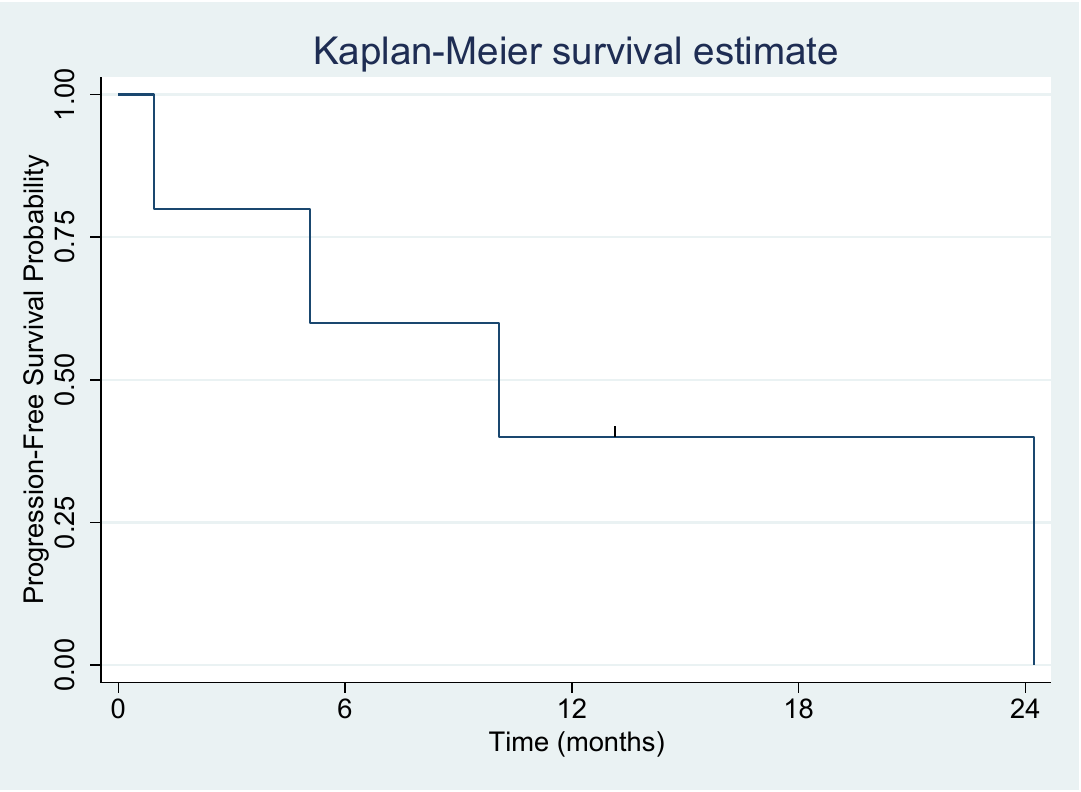
Figure 6. Overall median PFS on MMC treatment. Legend: Patient 3 did not progress and died of lung cancer, so was considered censored at the time of death. The median PFS was 10.1 months (95% CI = 0.9 months, upper bound not reached).